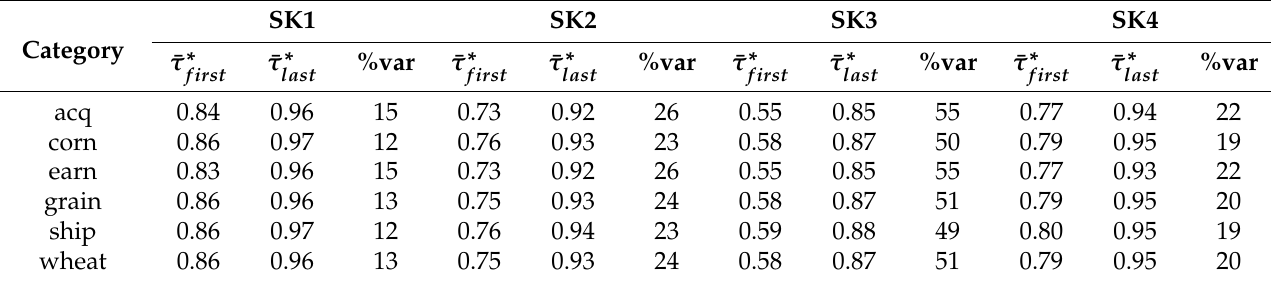
Table A1. Average of the computed collective concordance indices per category ( m = 2).